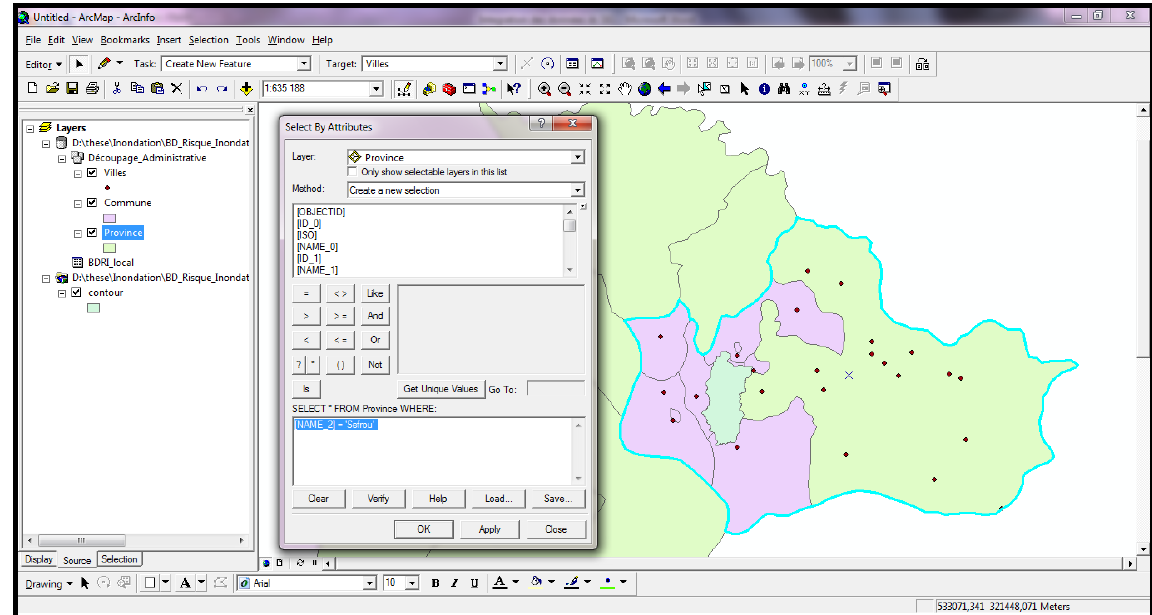
Fig.re 5 : Sélection par